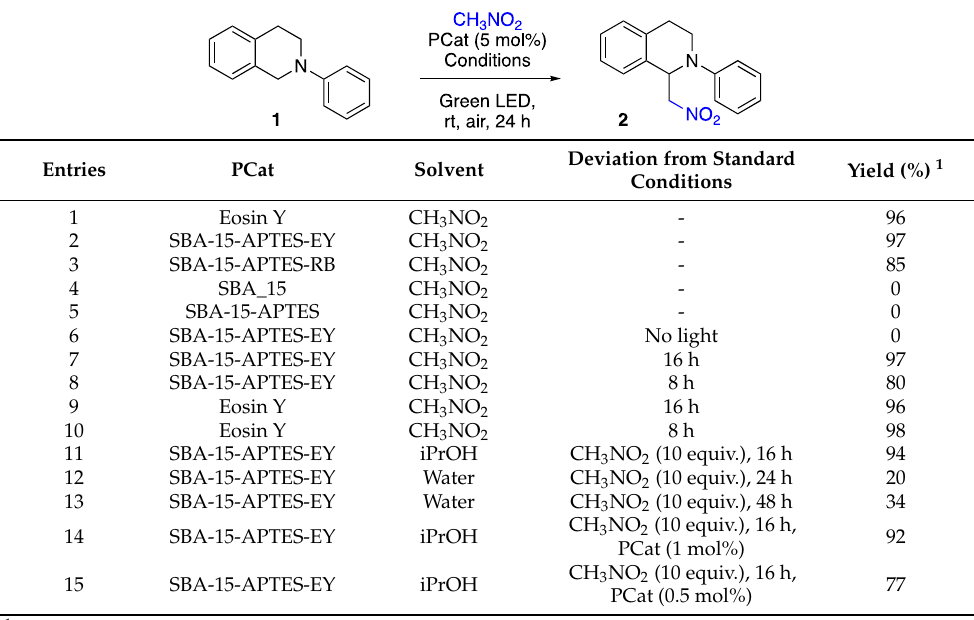
Table 2. Photocatalyzed aza-Henry reaction.